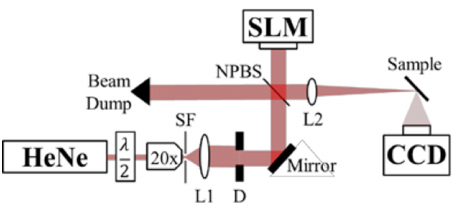
Figure 1. Reflective inverse diffusion setup. A vertically-polarized HeNe laser is expanded, collimated and normally incident on the SLM. The phase modulated beam is then focused onto the reflecting sample with a positive lens, and the reflected speckle pattern is recorded by the